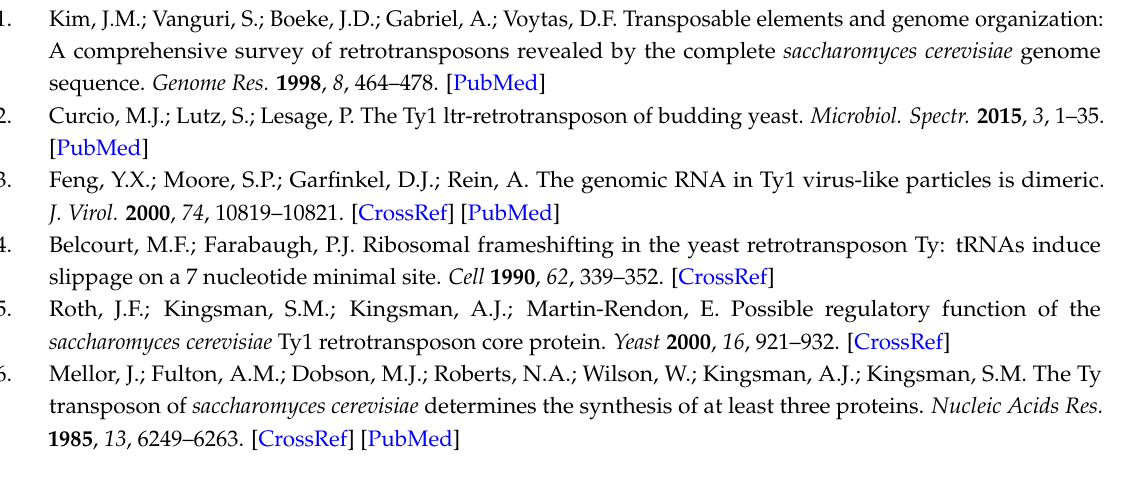
Figure S1: SHAPE reactivity AUG1GUG2 RNA mutant, Table S1: Primers used for construction of templates for in vitro transcription and reverse transcription, Table S2: Quantitation of the translation products from the gel in Figure 2, Data set S1: SHAPE data of AUG1AUG2